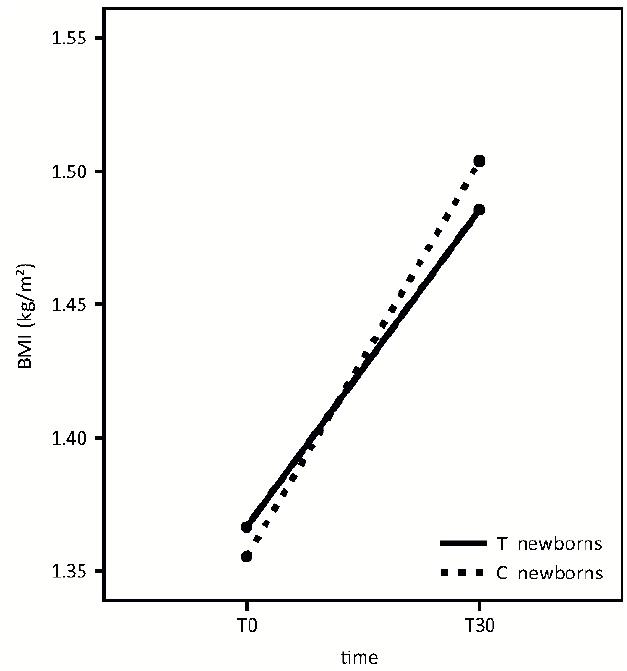
Figure 5. Growth pattern in treatment (T) and control (C) groups.